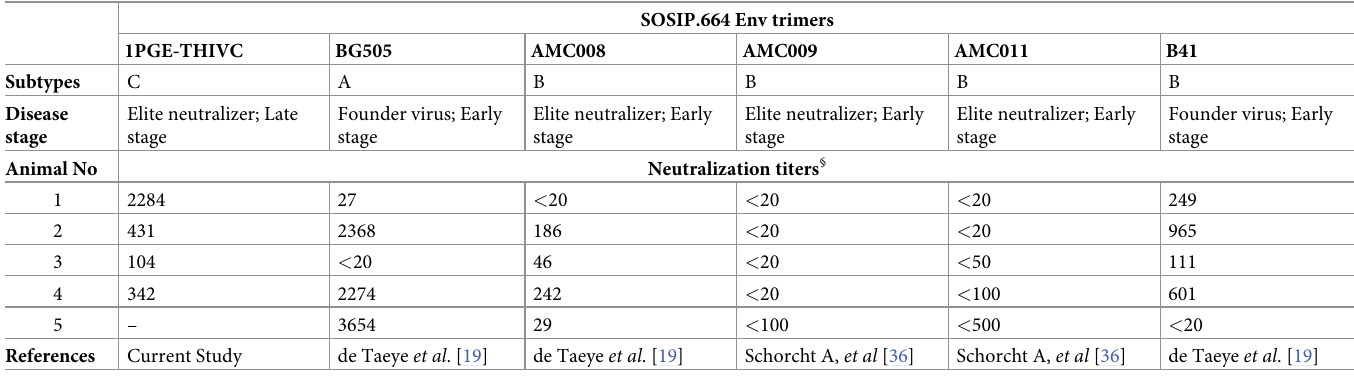
Table 2. Comparison of the rabbit serum autologous neutralization titers induced by different Env SOSIP trimers.